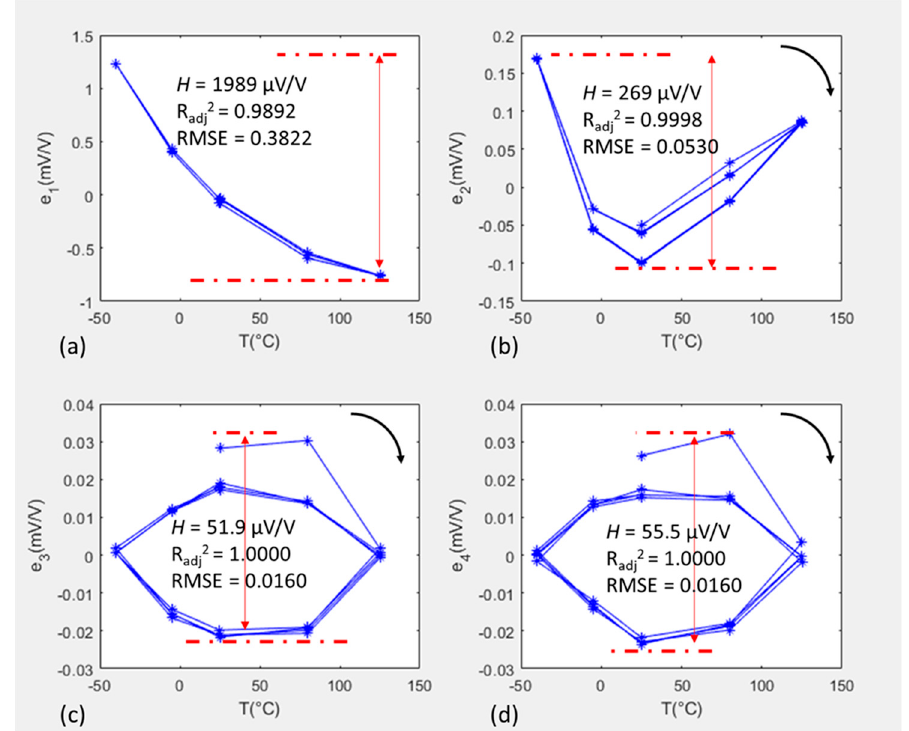
Figure 5. 100 kPa data for Unit #9 when L1 packaged and subjected to four extended temperature cycles. The figures show the errors after applying different order polynomial fits: ( a ) 1st order; ( b ) 2nd order; ( c ) 3rd order; and ( d ) 4th order.